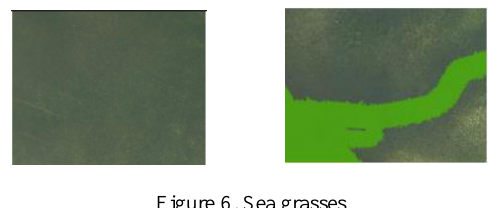
Figure 6. Sea grasses